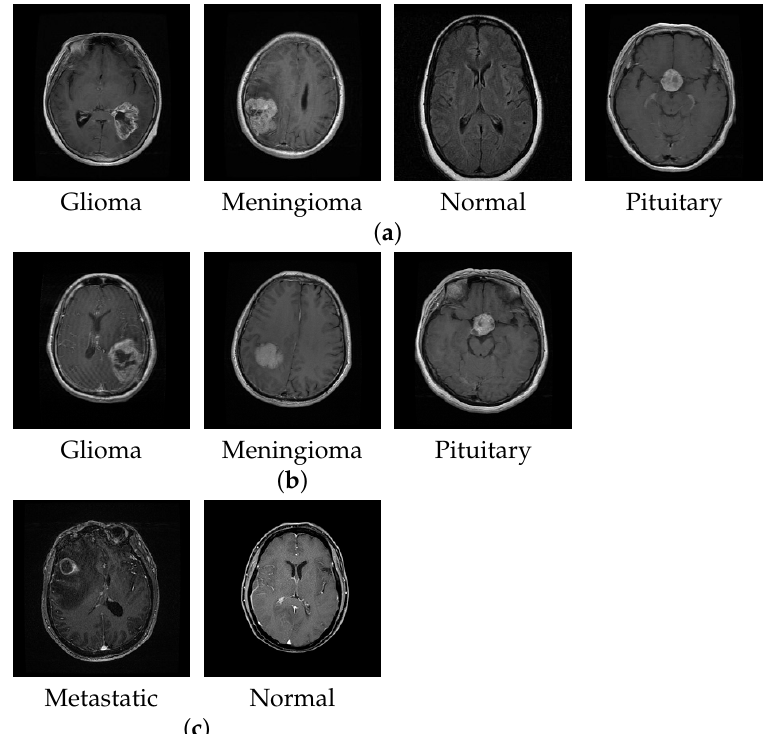
Figure 6. The examples of brain MRI slices in different datasets. ( a ) BT-4C, ( b ) BT-3C, ( c )